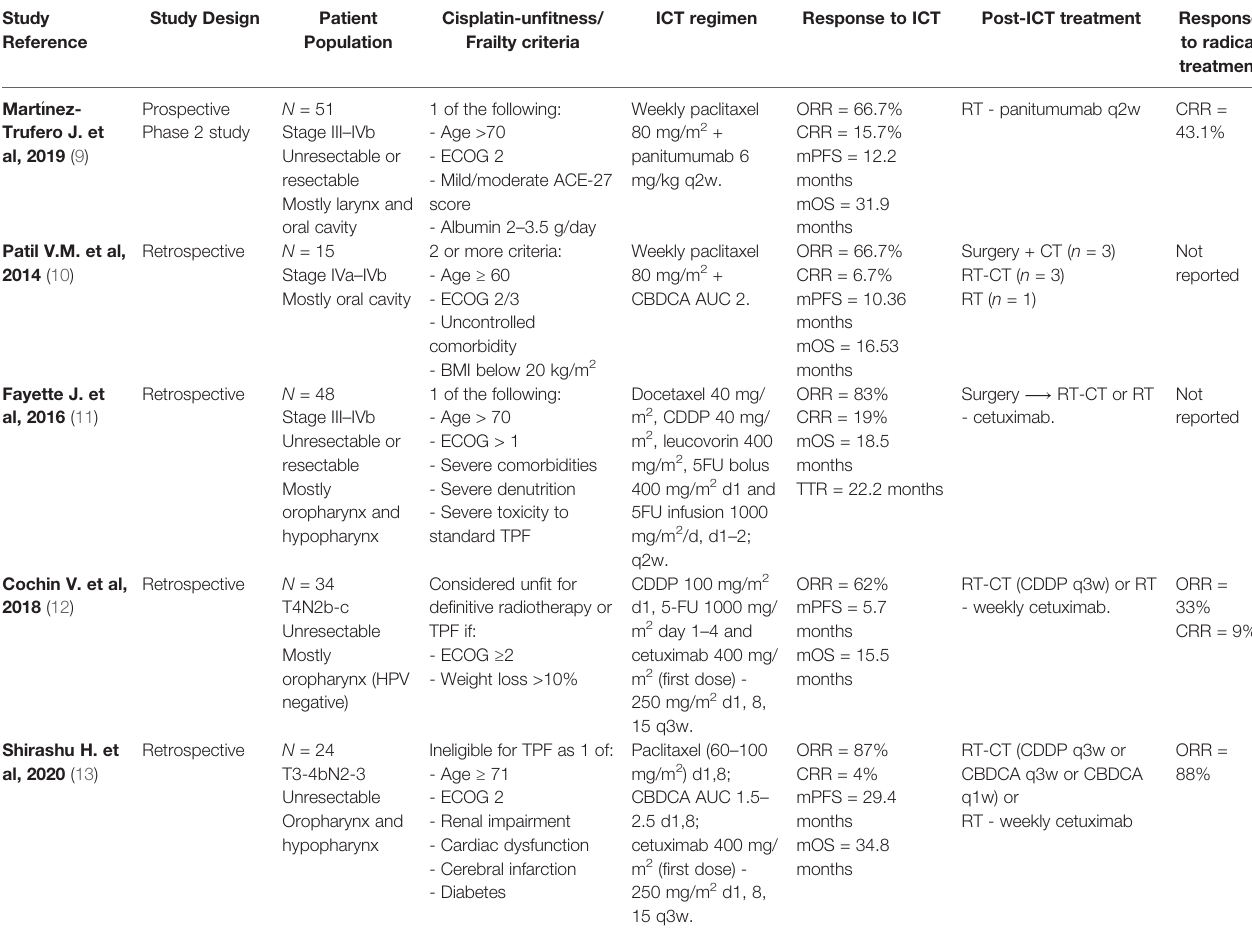
TABLE 1 | Summary of available evidence of studies in un fi t population for standard